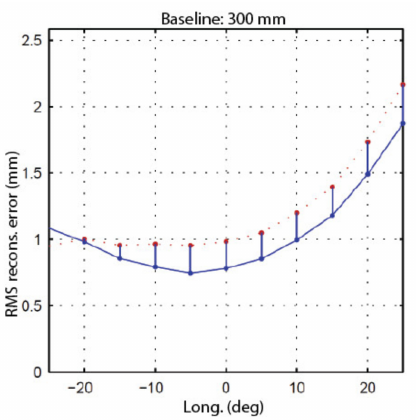
Figure 28. RMS reconstruction error of the 3D calibration target observed from the point of view located at 1.44 m from the ASP as a function of the direction of observation for a 300 mm baseline. = E = I , blue line E Red dots: E M M L C L M R C R , E M L C L calibrated with the proposed R C R